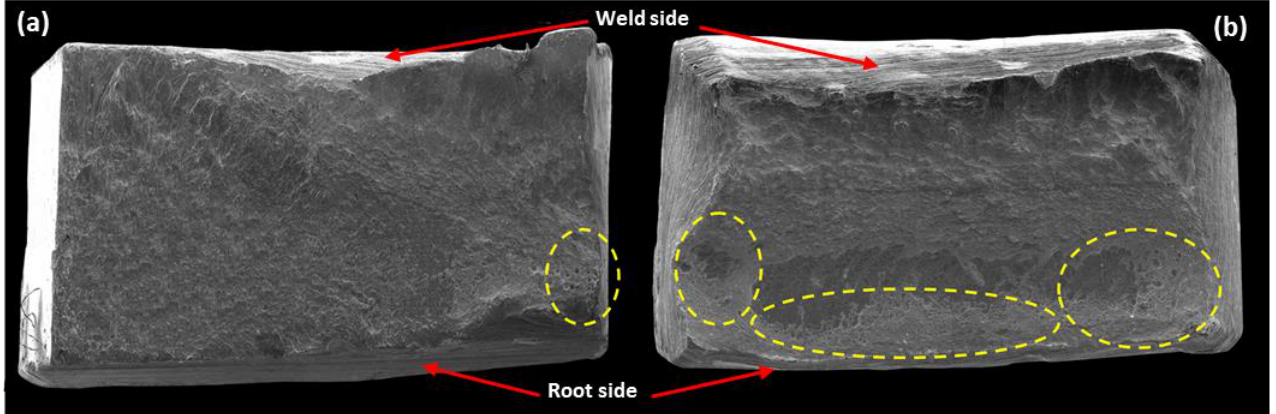
Figure 18. Failure surfaces at the staircase method: ( a ) AM-AM specimen fractured at (N: 1 757 738 cycle, σ a: 87.85 MPa), ( b ) AM-AM specimen fractured at (N: 239 732 cycle, σ a: 67.85 MPa).